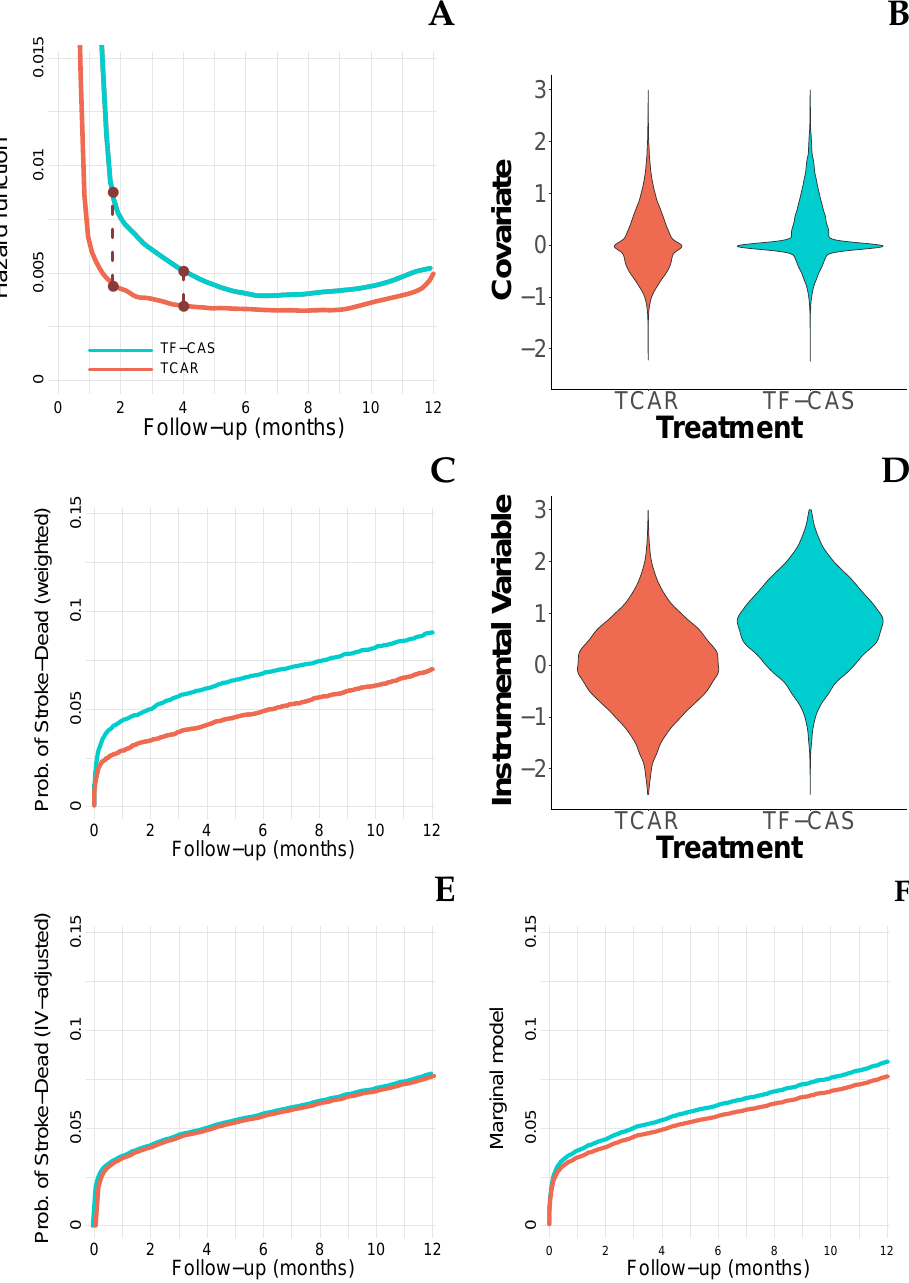
Figure 2. ( A ) Kernel-based estimation for the risk function in both TF-CAS and TCAR groups. ( B ) Violin-plots for the measured covariate by groups. ( C ) Propensity-score weighted Kaplan–Meier estimations by groups. ( D ) Violin-plots for the instrumental variable by groups. ( E ) Instrumental- variable adjusted survival curves. ( F ) Survival curves derived from the marginal